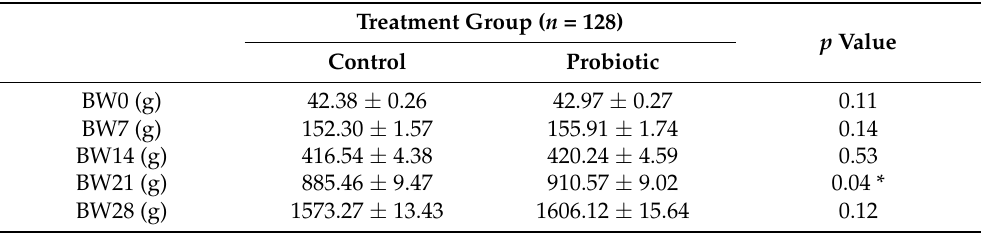
Table 4. The effect of the Bacillus mixture (F1) on performance parameters of broiler chickens from day 1 to 28 ( n = 256). The orange highlights indicate statistical significance with p value ≤